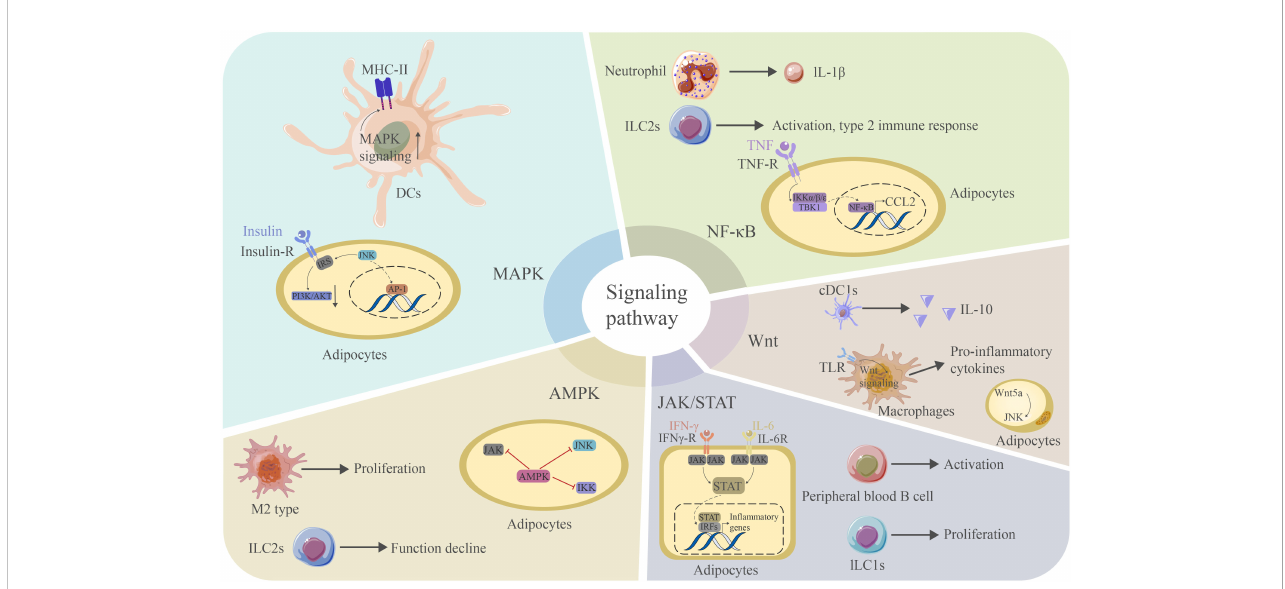
FIGURE 5 The MAPK signaling pathway is critical for the expression of MHC-II in DCs. JNK signaling can interact with IRS to reduce PI3K/AKT signaling and contribute. JNK can further promote AP-1 production and promote in fl ammation in adipose tissue. The NF- k B signaling pathway mediates the production of IL-1 b in neutrophils and the activation of ILC2s. This pathway is also essential for the adipocyte response to TNF and the production of CCL2. Wnt signaling mediates IL-10 production in CDC1s and binds TLR to produce proin fl ammatory cytokines in macrophages. Wnt5a can induce JNK in adipocytes. The JAK/STAT signaling pathway is essential for activating peripheral blood B cells and the proliferation of ILC1s. This pathway is also critical for the adipocyte response to IFN- g . STATs can further bind IRFs to induce the production of proin fl ammatory cytokines. The AMPK signaling pathway mediates the proliferation of M2-type macrophages and blocks the proin fl ammatory signaling pathway in adipocytes. However, it may cause a decrease in the function of ILC2s. AP-1 activator protein 1, CCL2 chemokine ligand 2, TLR toll-like receptor, IRF interferon regulation